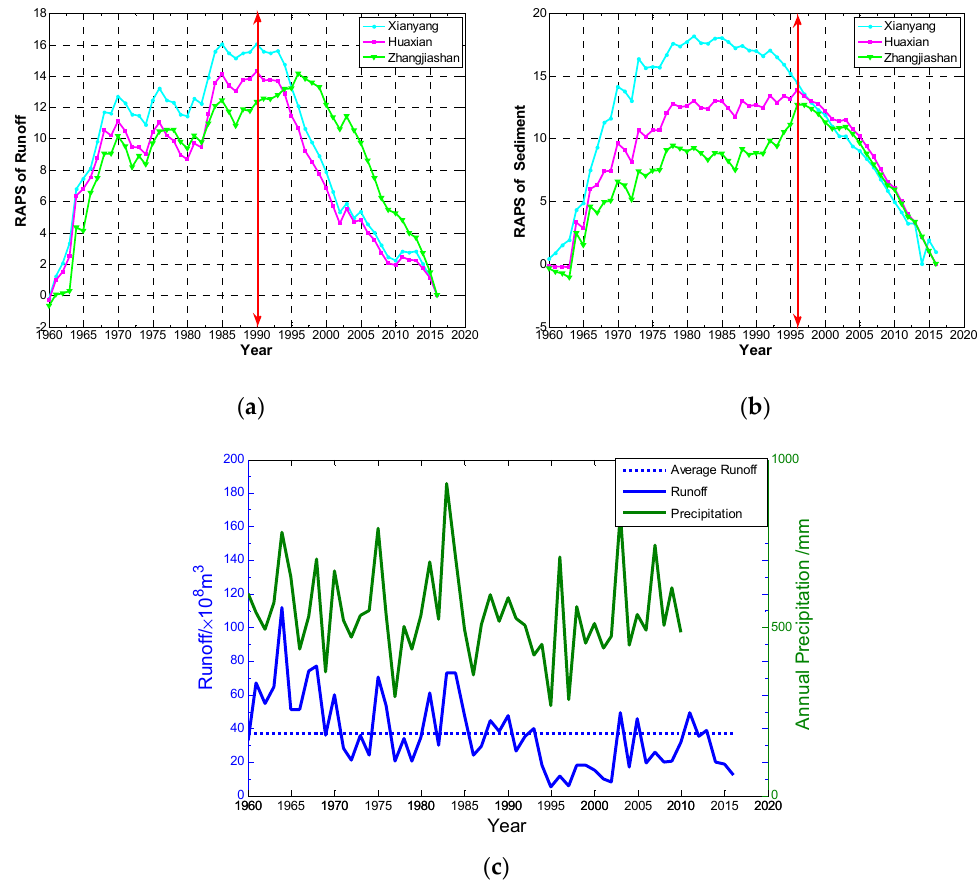
Figure 3. Figure of annual runoff, sediment, and precipitation yield of Xianyang Station, Zhangjiashan Station, and Huaxian Station. ( a ) RAPS figure of annual runoff. ( b ) RAPS figure of annual sediment. ( c ) Figure of annual precipitation and runoff of Xianyang Station.